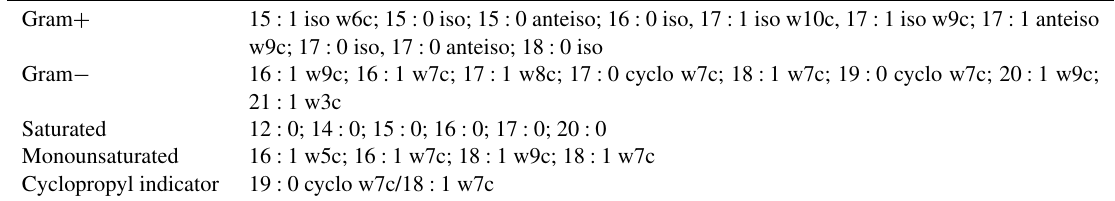
Table A1. PLFA (phospholipid fatty acid) assignments taken from Bossio and Scow (1998). Gram +